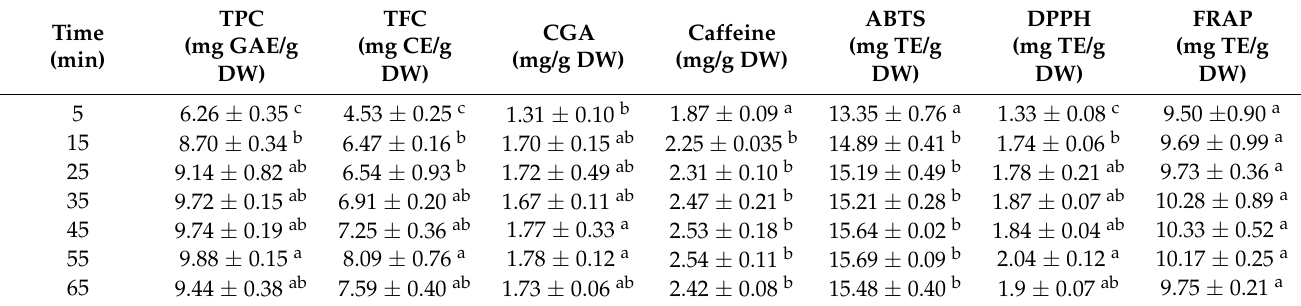
Table 1. Effect of ultrasonic time on recovery of bioactive compounds and antioxidant from coffee